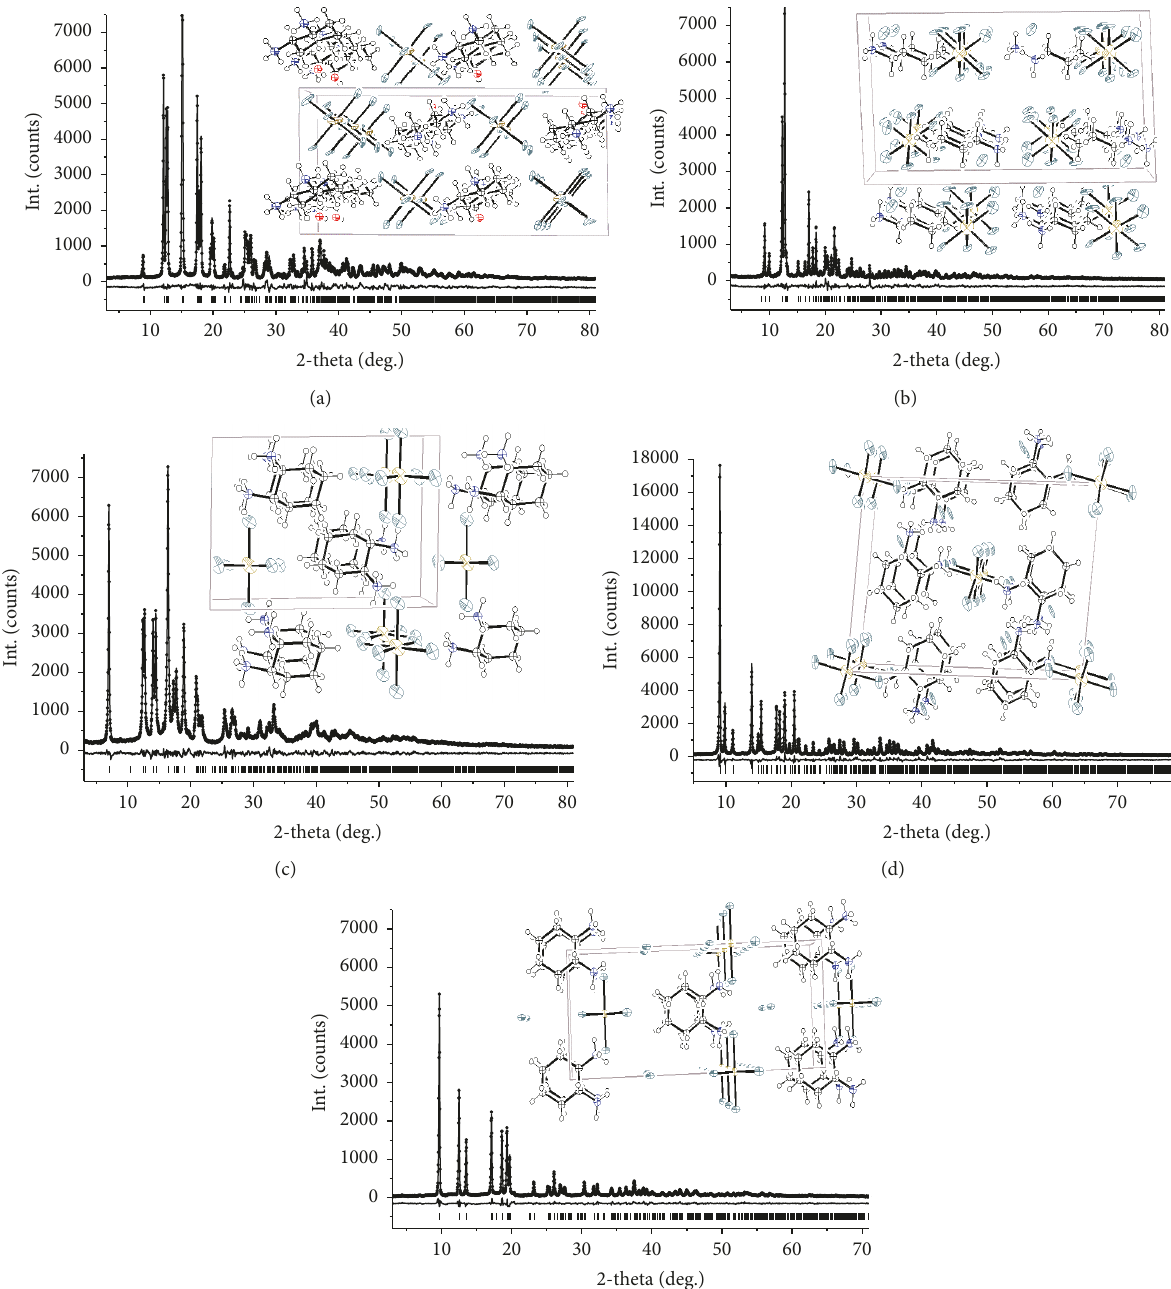
Figure 5: Crystal structures and Rietveld plots of the investigated compounds. (a) C 6 H 10 (NH 3 ) 2 [PtCl 6 ] ⋅ H 2 O (I) ,